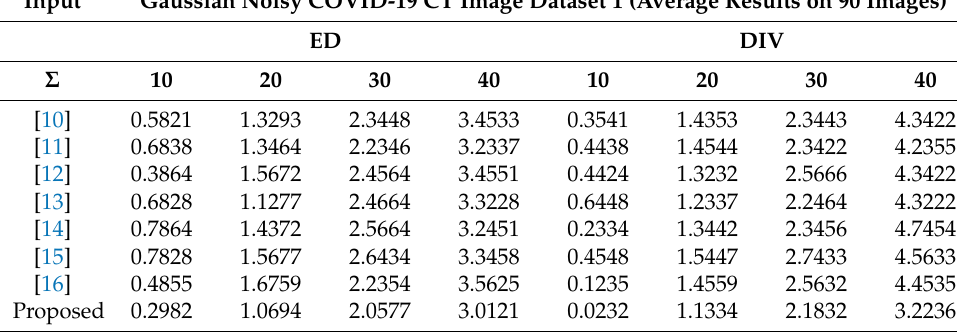
Table 3. ED and DIV of noiseless CT images.